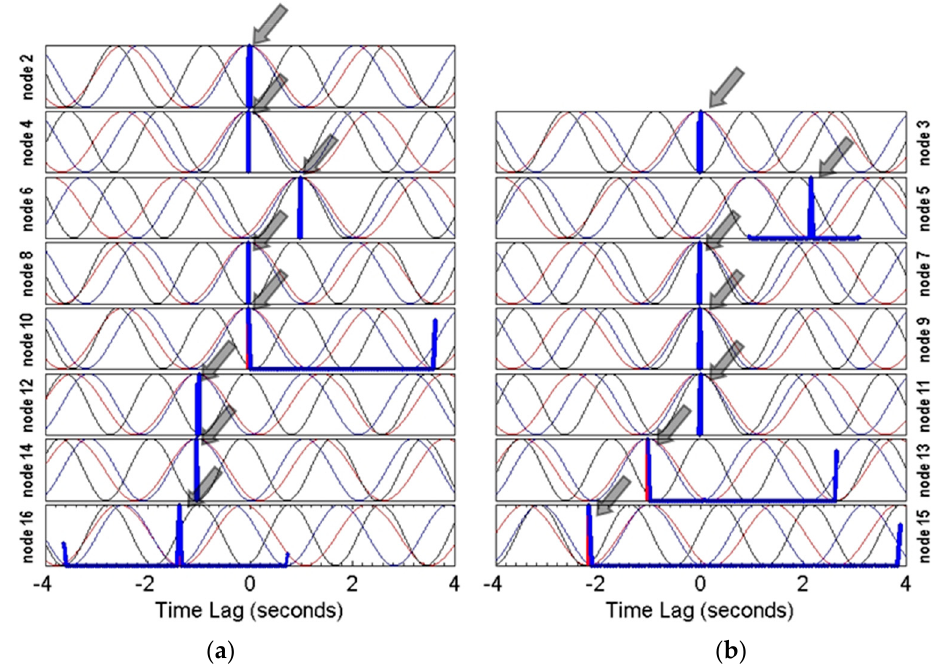
Figure 17. PATL ( a ) and KDF ( b ) plots for all the nodes in the building. Note that most of the nodes have single-peaked KDF. Arrows show the top ranked solutions selected for the first iteration.